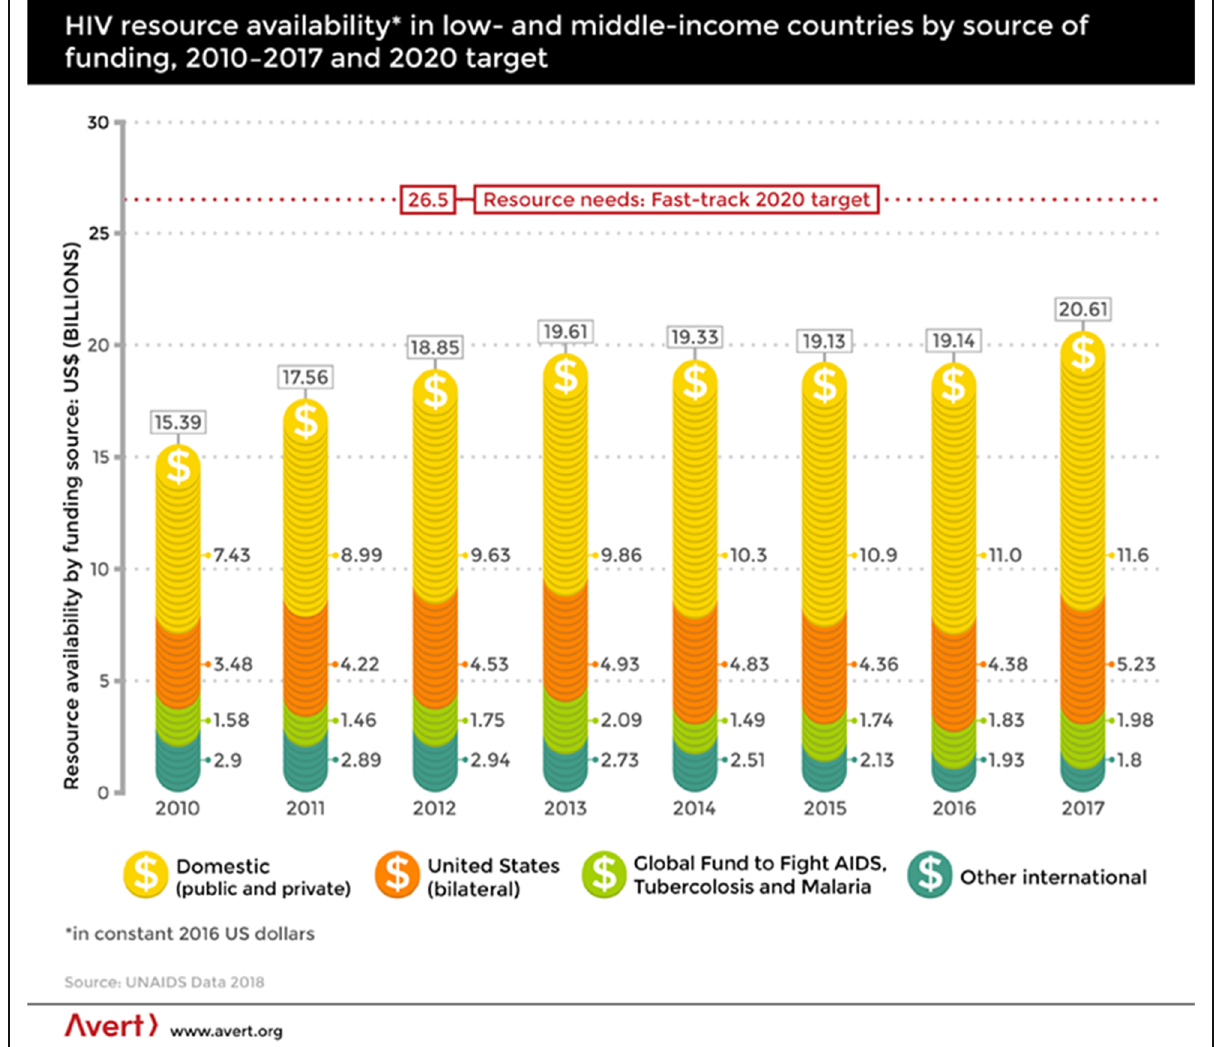
Fig. 2 HIV resource availability in low and middle income